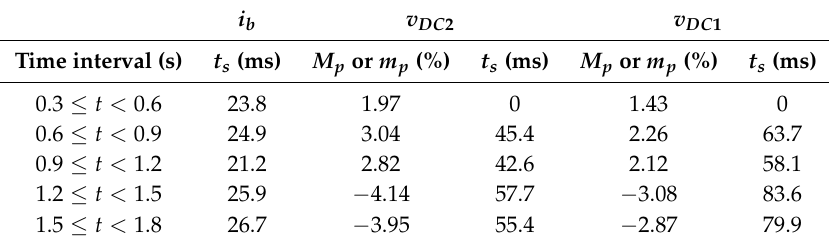
Table 8. Overshoot ( M p > 0) or undershoot ( m p < 0), and 2%-settling time ( t s ) in the V2G mode for i b , v DC 2 , and v DC 1 .